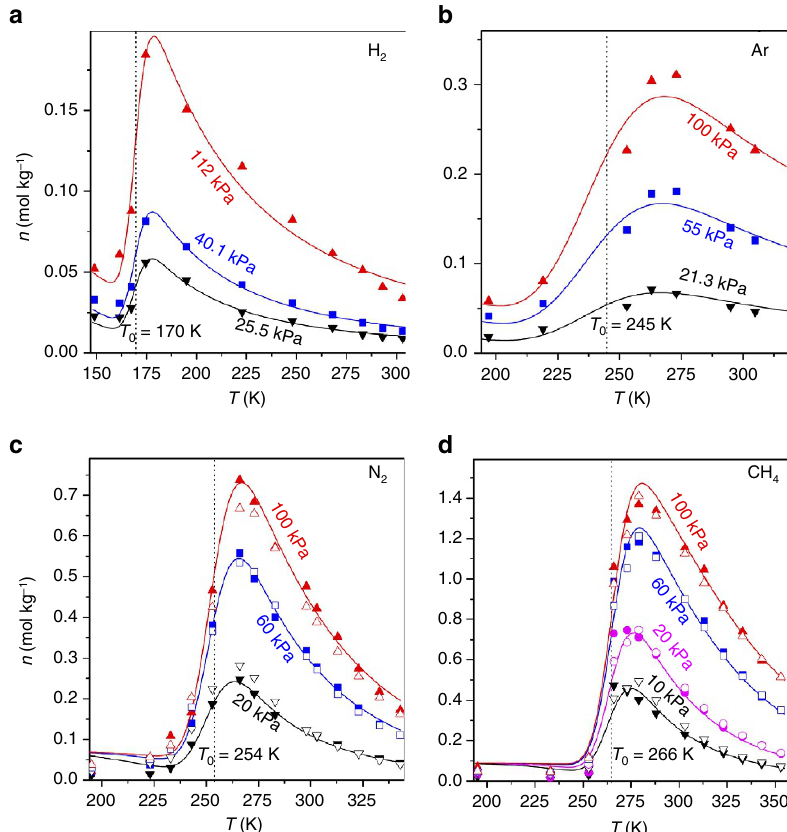
Figure 3 | Representative adsorption isobars for four gases on the potassium chabazite. Experimentally measured data together with the GCMC calculations and a demonstration of the LJM model’s ability to quantify the effect of temperature-regulated guest admission. ( a ) H 2 at 11 different temperatures; ( b ) Ar at 7 temperatures; ( c ) N 2 at 14 temperatures; ( d ) CH 4 at 13 temperatures. Only 1/6 th of the isobar data points measured and used in the regression are shown here for clarity. Full isotherm/isobar data across the experimental pressure range 2–120kPa can be found in Supplementary Figs 14–17. The full set of N 2 and CH 4 GCMC calculations are presented in Supplementary Figs 10 and 11. Solid symbols denote experimental data, hollow symbols represent the GCMC calculated capacities, and solid curves correspond to the LJM-Langmuir model. The dotted lines represent the threshold admission temperature T 0 determined using the LJM model. NATURE COMMUNICATIONS|8:15777|DOI: